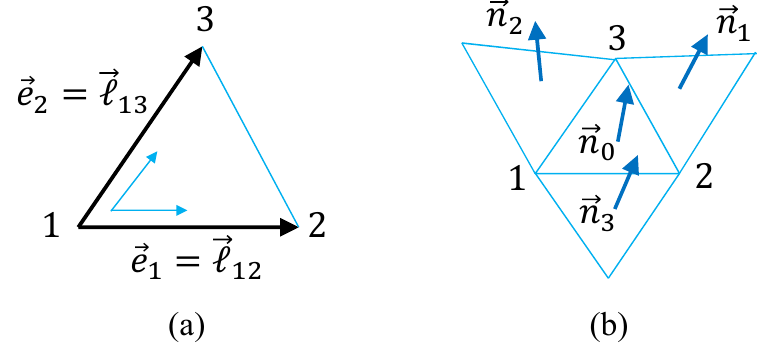
Figure 3. Lattice structure for discretization of the canonical surface model. ( a ) A local coordinate on (cid:126)(cid:96) (cid:126)(cid:96) the triangle 123 with the edge vectors 12 and 13 , and ( b ) the triangle 123 and its three nearest-neighbor triangles, where the normal vector n 0 interacts with n i ( i = 1,2,3 ) . The local coordinate in ( a ) is exactly the same as that in Figure